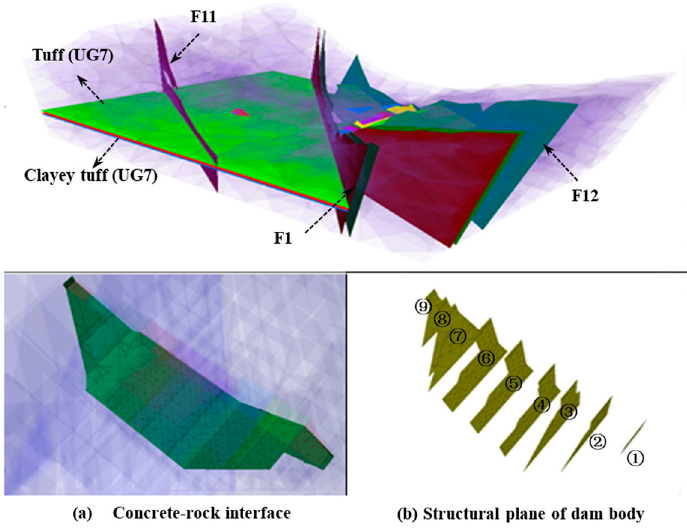
Figure 4. Concrete-rock interface and the seams between Capulin San Pablo dam sections.